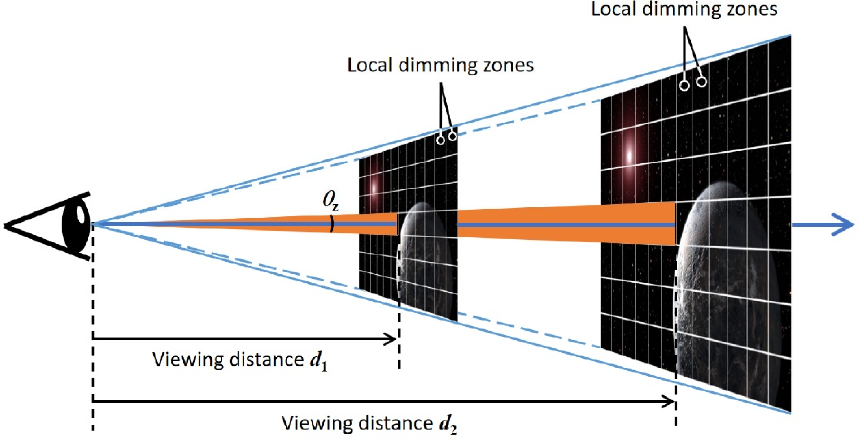
Figure 6. Conceptual diagram of scaling up display size based on same angular size [25].